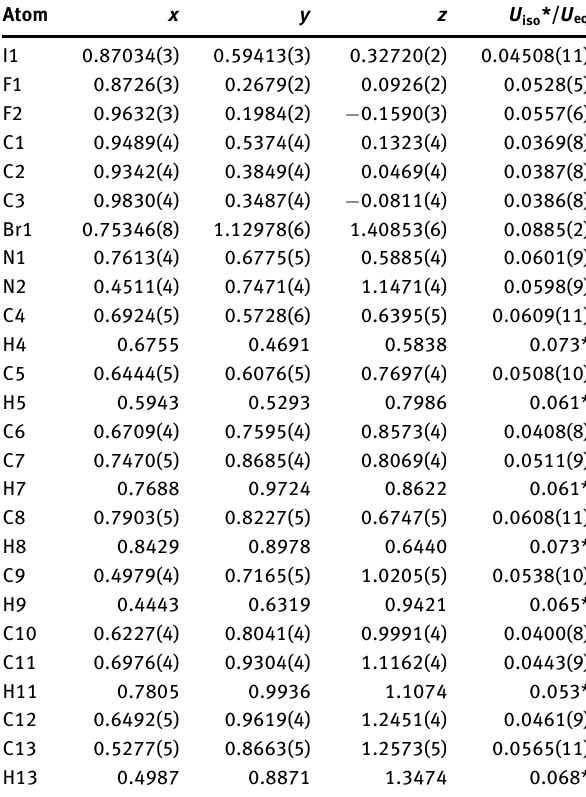
stacking interaction between 5-bromo-3,4-bipyridine and 1,4-diiodotetrafluorobenzene is 9.07 kcal/mol; the